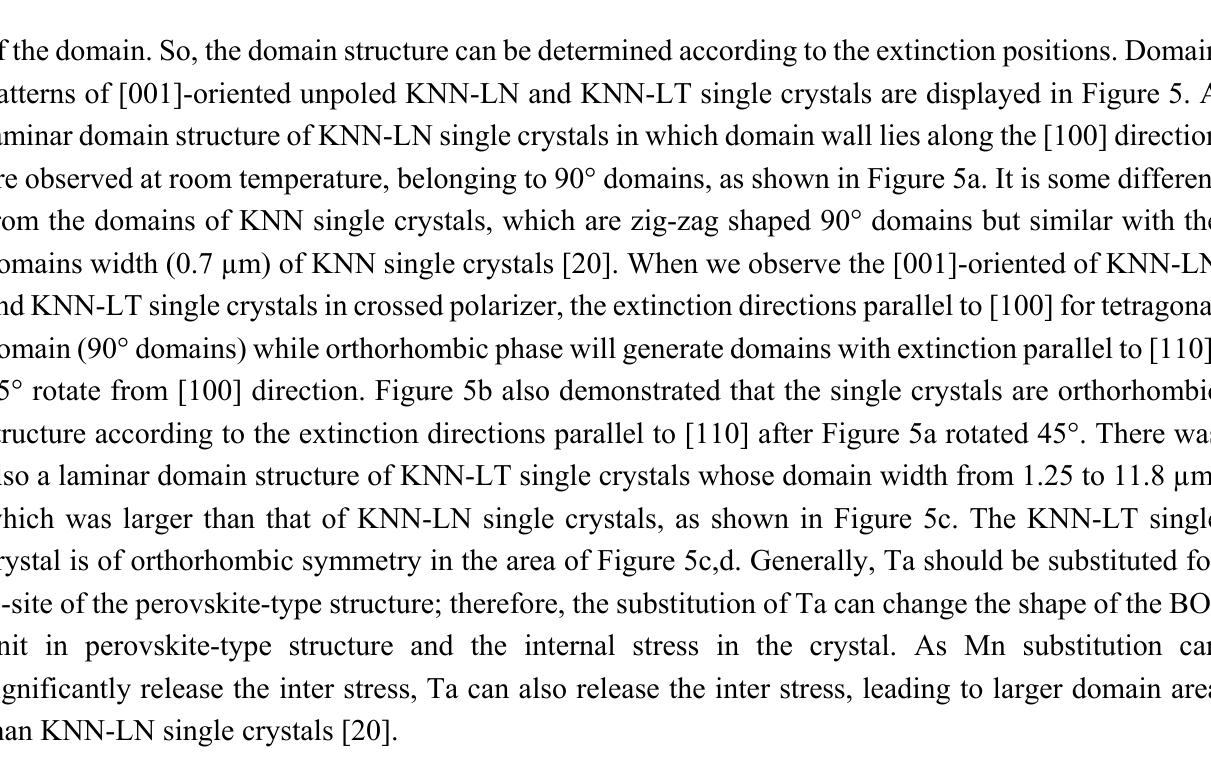
Figure 5. Domain patterns of [001]-oriented single crystals under crossed polarizer at room temperature: ( a ) and ( b ) for KNN-LN; ( c ) and ( d ) for